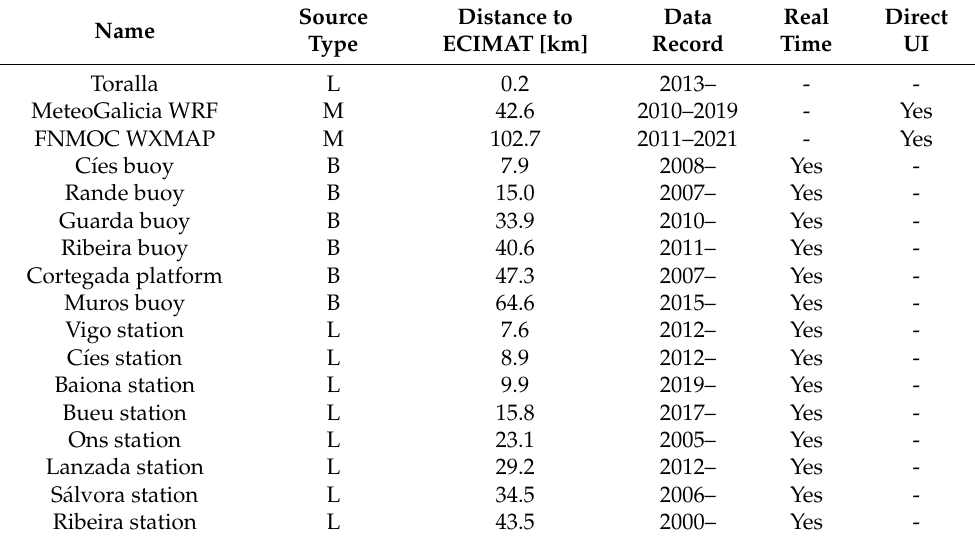
Table 1. Data sources for upwelling index